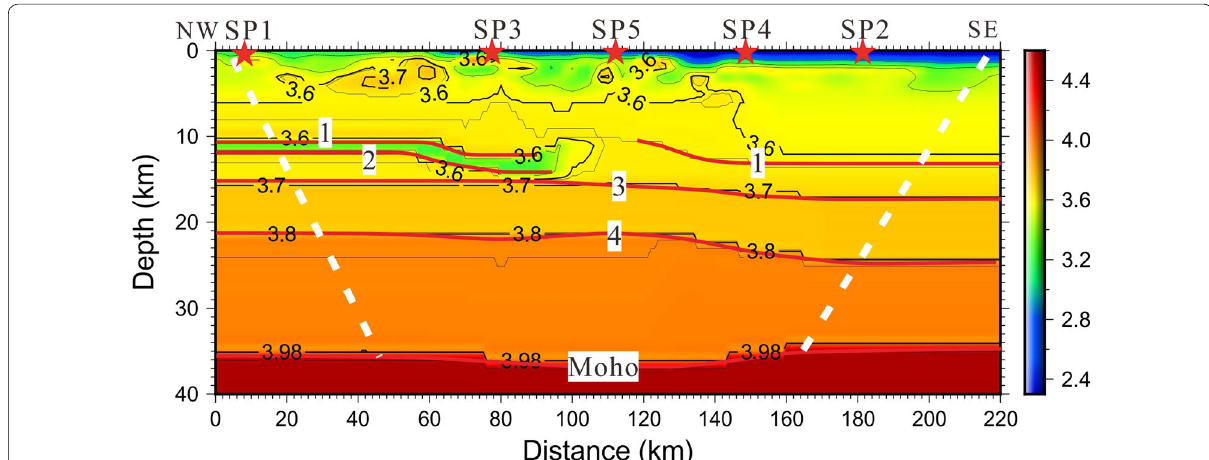
Fig. 8 S-wave velocity structure along the Line 1 seismic profile. The red line indicates the reflection boundaries used in the inversion. The red stars indicate the shotpoints (SP). As is evident in the seismic ray diagrams (Fig. 9), there is no seismic coverage beyond the white dash lines. The wide-angle reflections S1S, S2S, S3S, S4S, and PmP are generated from boundaries 1, 2, 3, 4, and Moho, respectively